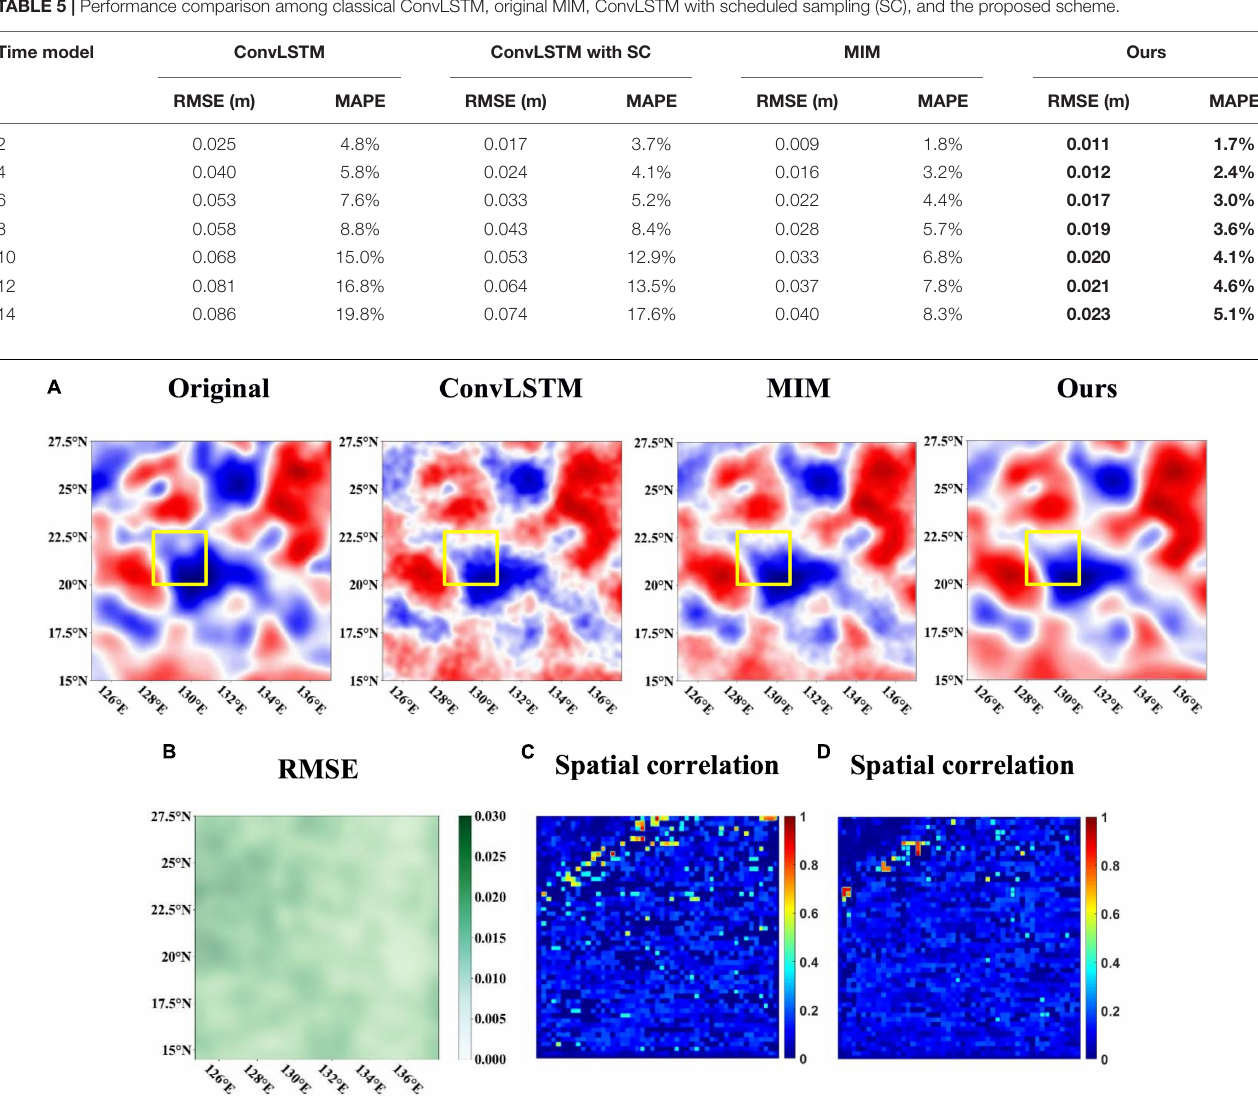
FIGURE 7 | Example SLA prediction results and pointwise prediction performance for a 14-day prediction duration. (A) The example SLA prediction results from the classic ConvLSTM, the original MIM, and our proposed scheme. (B) RMSE spatial distribution for example SLA prediction with our proposed scheme. (C) Spatial correlation map between RMSE and cyclonic density distribution. (D) Spatial correlation map between RMSE and anticyclonic density